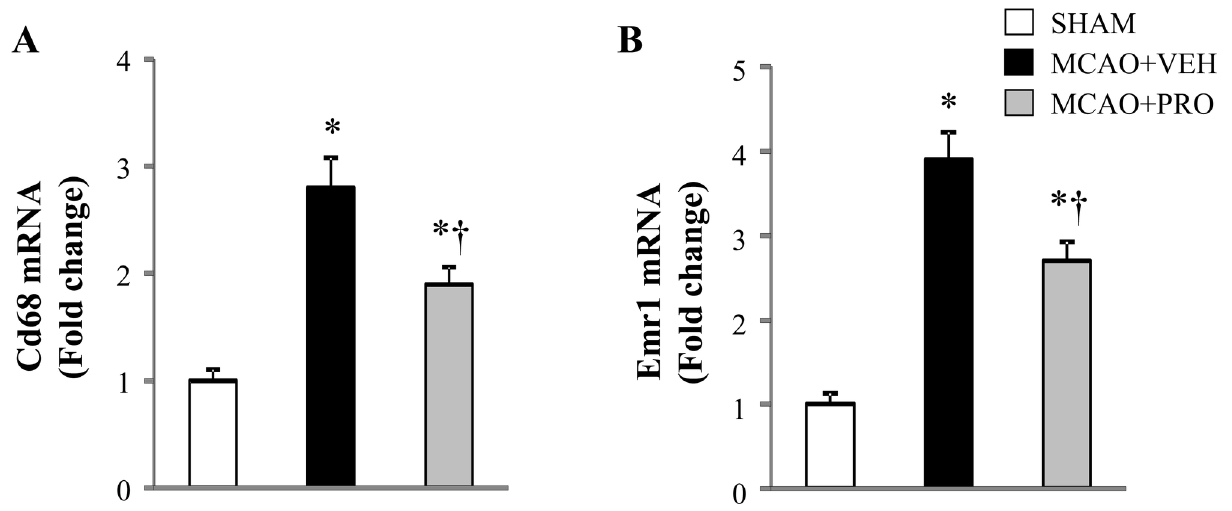
Figure 2. mRNA expression for microglia specific markers Cd68 (A) and Emr1 (B) in the peri-infarct cortical tissue 24 h after MCAO in rats treated with VEH or PRO. SHAM rats without treatment were used as control. Values are mean ± SEM (n = 8 for each group) and expressed as a fold change relative to SHAM. * P < 0.05 vs. SHAM, † P < 0.05 MCAO+PRO vs. MCAO+VEH. doi: